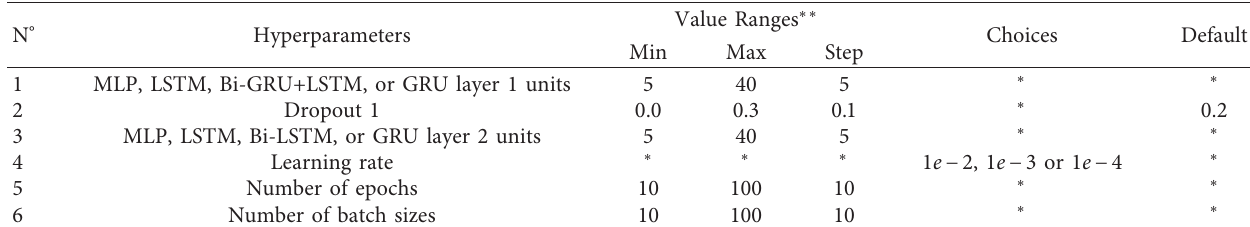
Figure 7: Data analysis flow chart proposed for the Table 1: Model hyperparameter choices or value ranges for optimization by keras tuner.